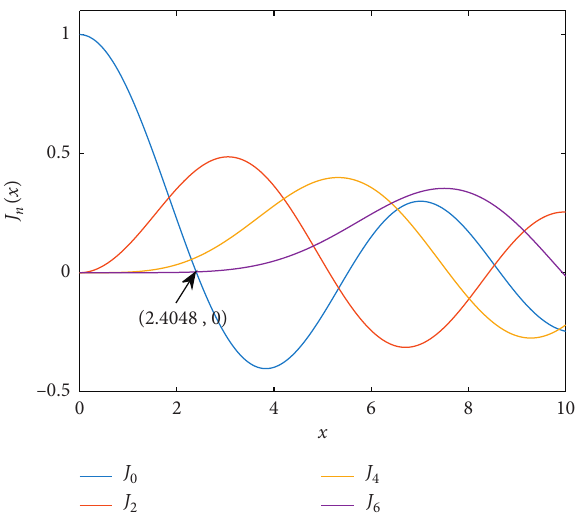
Figure 9: The Bessel function graph of order 2 n .